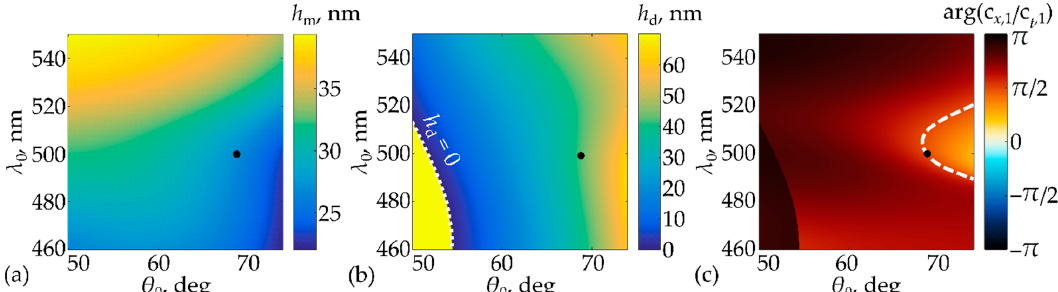
Figure 2. Thicknesses of the metal ( a ) and dielectric ( b ) layers (along the white dotted line in ( b ), the dielectric layer thickness vanishes) of the structure as a function of wavelength and angle of incidence, at which zero reflection is achieved; ( c ) Argument difference ψ = arg ( c x ,1 / c t ,1 ) (white dashed line shows the points, at which ψ = π /2 ). Bold black dots correspond to the parameters of the example considered in subsection 4.2.